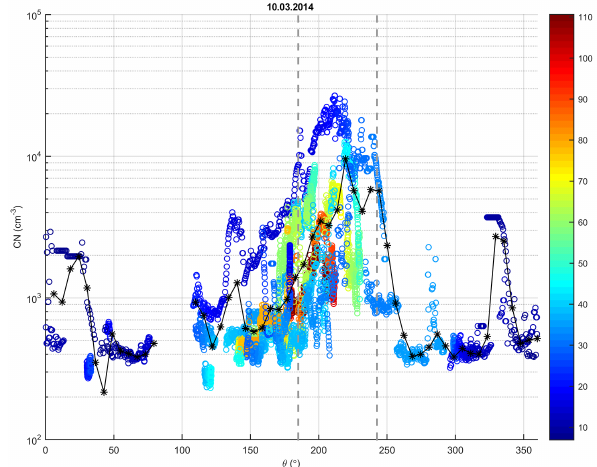
Figure 3. CN concentrations around Manaus for 10 March 2014. θ is the azimuth angle, is zero for east, and grows anticlockwise. Colours are proportional to the horizontal distance (km) between Manaus airport and the aircraft. The black dots represent the angu- lar mean CN concentration for each of the 60 bins (azimuth). The vertical dashed lines represent the limits of the plume location.